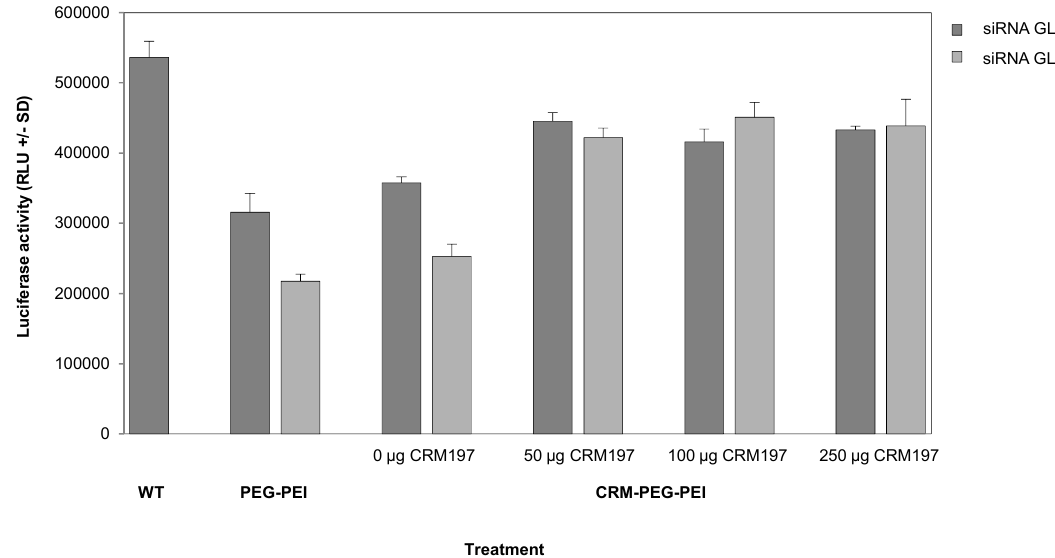
Figure 4. Competition of CRM197-mediated cellular uptake of CRM-PEG-PEI/siRNA complexes and siRNA-mediated knockdown in transiently luciferase expressing U87 cells. Comparison of luciferase activity in cells transfected with DNA (WT) and cells transfected with PEG-PEI/siRNA complexes or CRM197-PEG-PEI/siRNA complexes containing a non-specific siRNA (siRNA GL2; dark grey) or the luciferase-specific siRNA GL3 (light grey), respectively. CRM197-mediated uptake of CRM197-PEG-PEI/siRNA complexes was inhibited by addition of free CRM197 peptide 30 min prior to